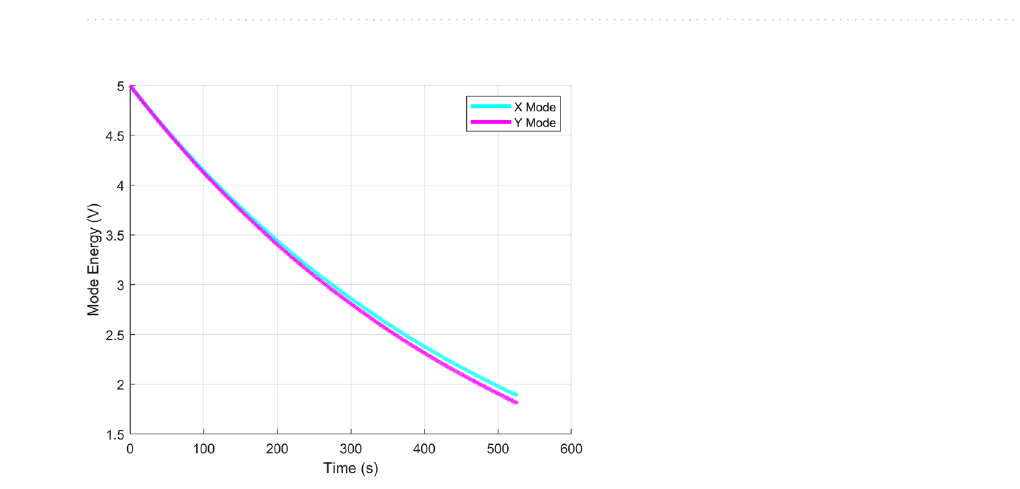
Figure 9. Experimental setup of the HRG RIG.